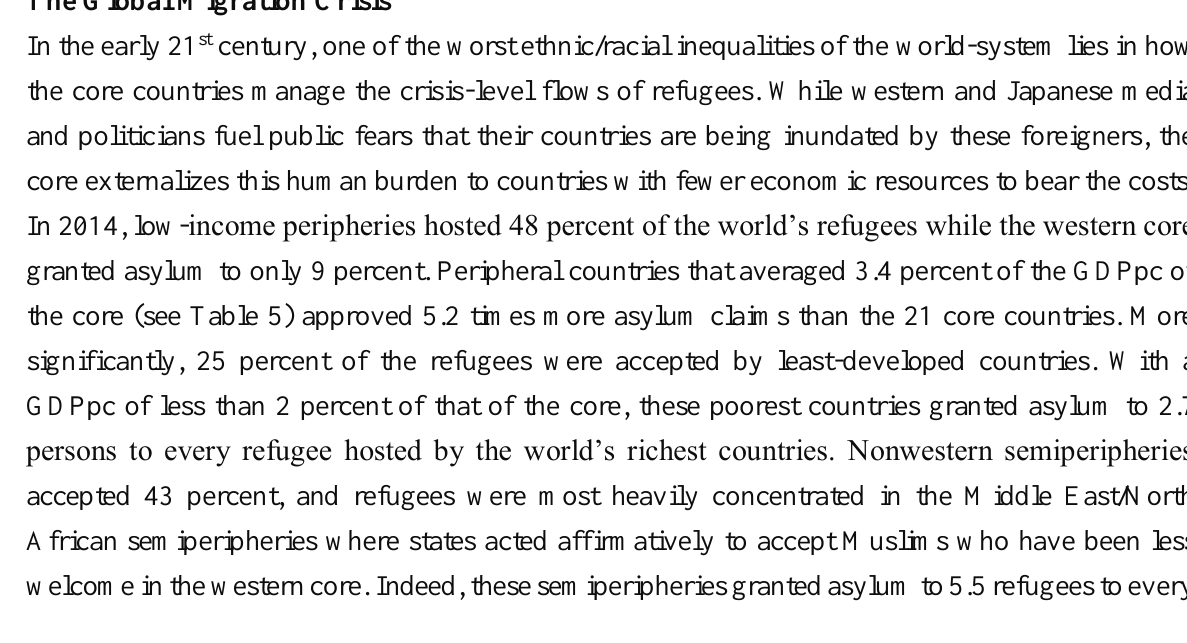
Table 2 with the list of countries in which citizens were displaced (International Displacement Monitoring Centre